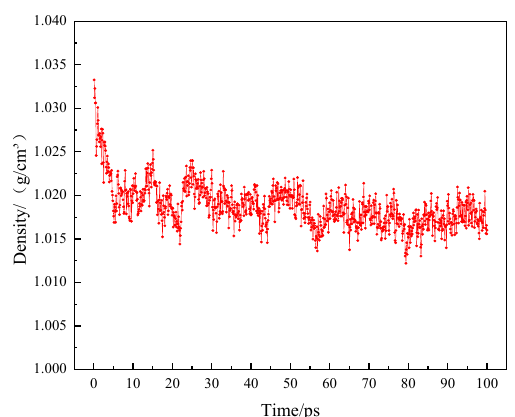
Figure 4. The density of the asphalt model during simulation. The compatibility of polymers is also an important indicator for the rationality verification of the model. The solubility parameter, as a physical parameter to evaluate the degree of compatibility between different polymer molecules, can be used as the basis for the verification of the molecular compatibility of each component in asphalt. For the solubility parameter (SP) of 12 asphalt molecules, the calculation formula is shown in Equation (1), and the obtained data is shown in Table 2.